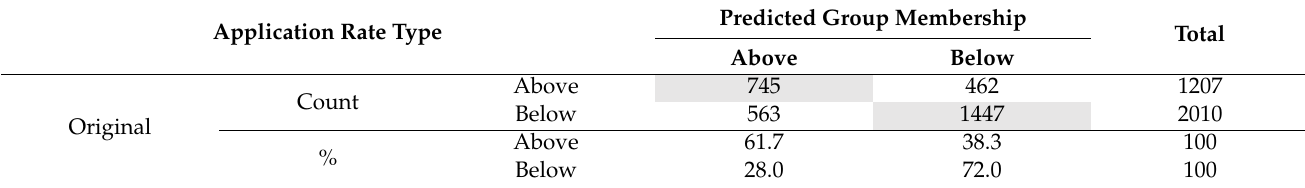
Table 4. Discriminant analysis results with rurality #.